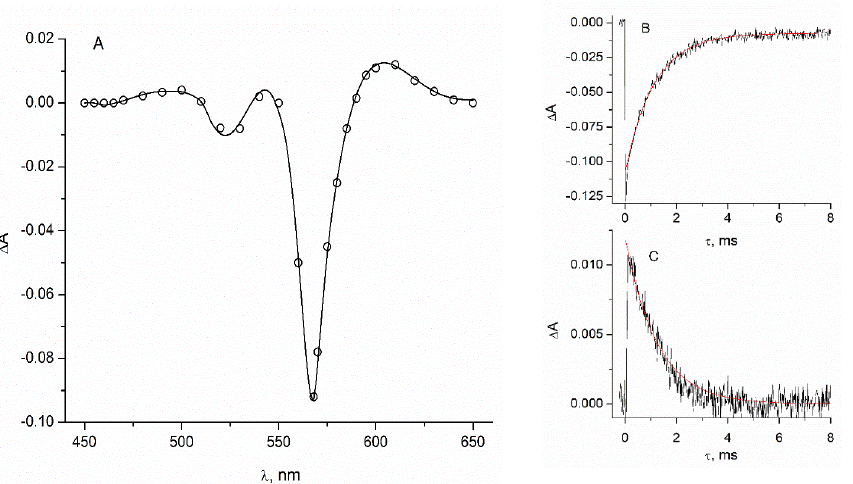
Figure 22. ( A ) Difference absorption spectrum of dye 21 photoisomer in isopropanol solution ( c dye ~1.1 × 10 –6 mol L − 1 ), obtained by flash photolysis (measured 70 µ s after the front of the flash); ( B,C ) decay kinetics of the dye photoisomer due to back dark isomerization at ( B ) λ reg = 568 nm (at photobleaching maximum) and ( C ) λ reg = 610 nm (at photoisomer absorption maximum). Interaction with DNA also hinders photoisomerization processes in molecules of oxacarbocyanine dyes 16 , 29, and 30 . Upon flash photoexcitation of aerated solutions of dye 16 in the presence of dsDNA ( c DNA = 2.4 × 10 –4 mol L − 1 ), the intensity of the absorption signal of the photoisomer decreased, and its lifetime increased. For meso ‐ substituted oxa ‐ dyes 29 and 30 at c DNA = 4.4 × 10 –5 mol L − 1 and higher, no photoisomer signals were ob ‐ served [107].